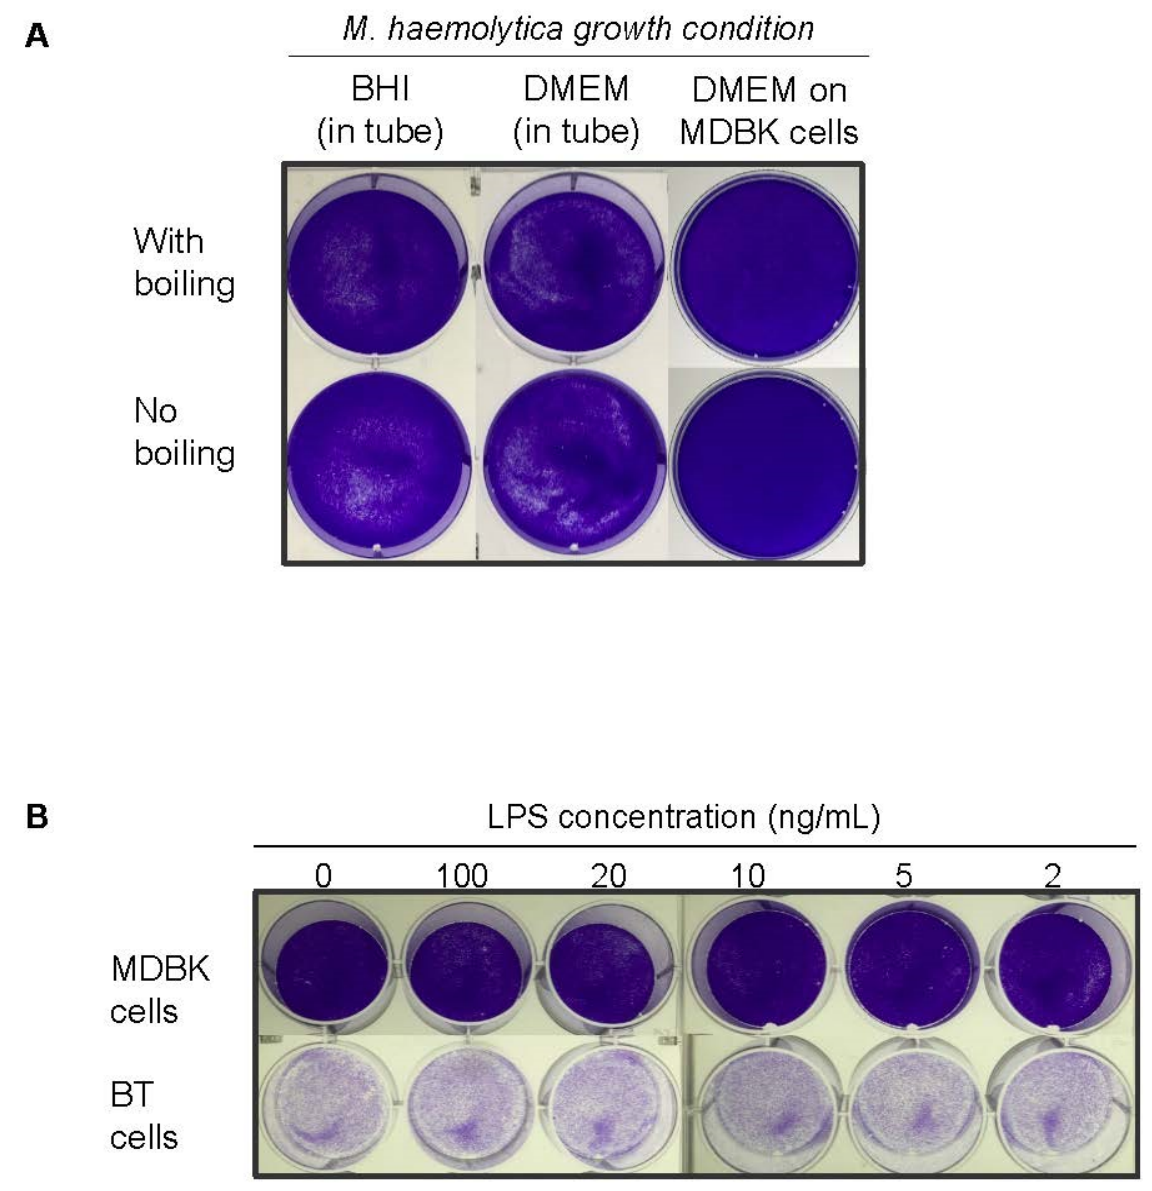
Figure 5. M. haemolytica may not produce soluble factors cytolytic to MDBK or BT cells. ( A ) An overnight culture of M. haemolytica was diluted 1:100 and incubated either in a tube with fresh BHI or fresh DMEM, or in DMEM in the presence of MDBK cells. After 8 h, filtered supernatants were boiled or left untreated and applied to fresh cell monolayers. Cells were washed, fixed and stained 24 h after treatment. ( B ) LPS was directly applied to fresh MDBK and BT cell monolayers at the indicated concentrations. Cells were washed, fixed and stained 24 h after treatment.